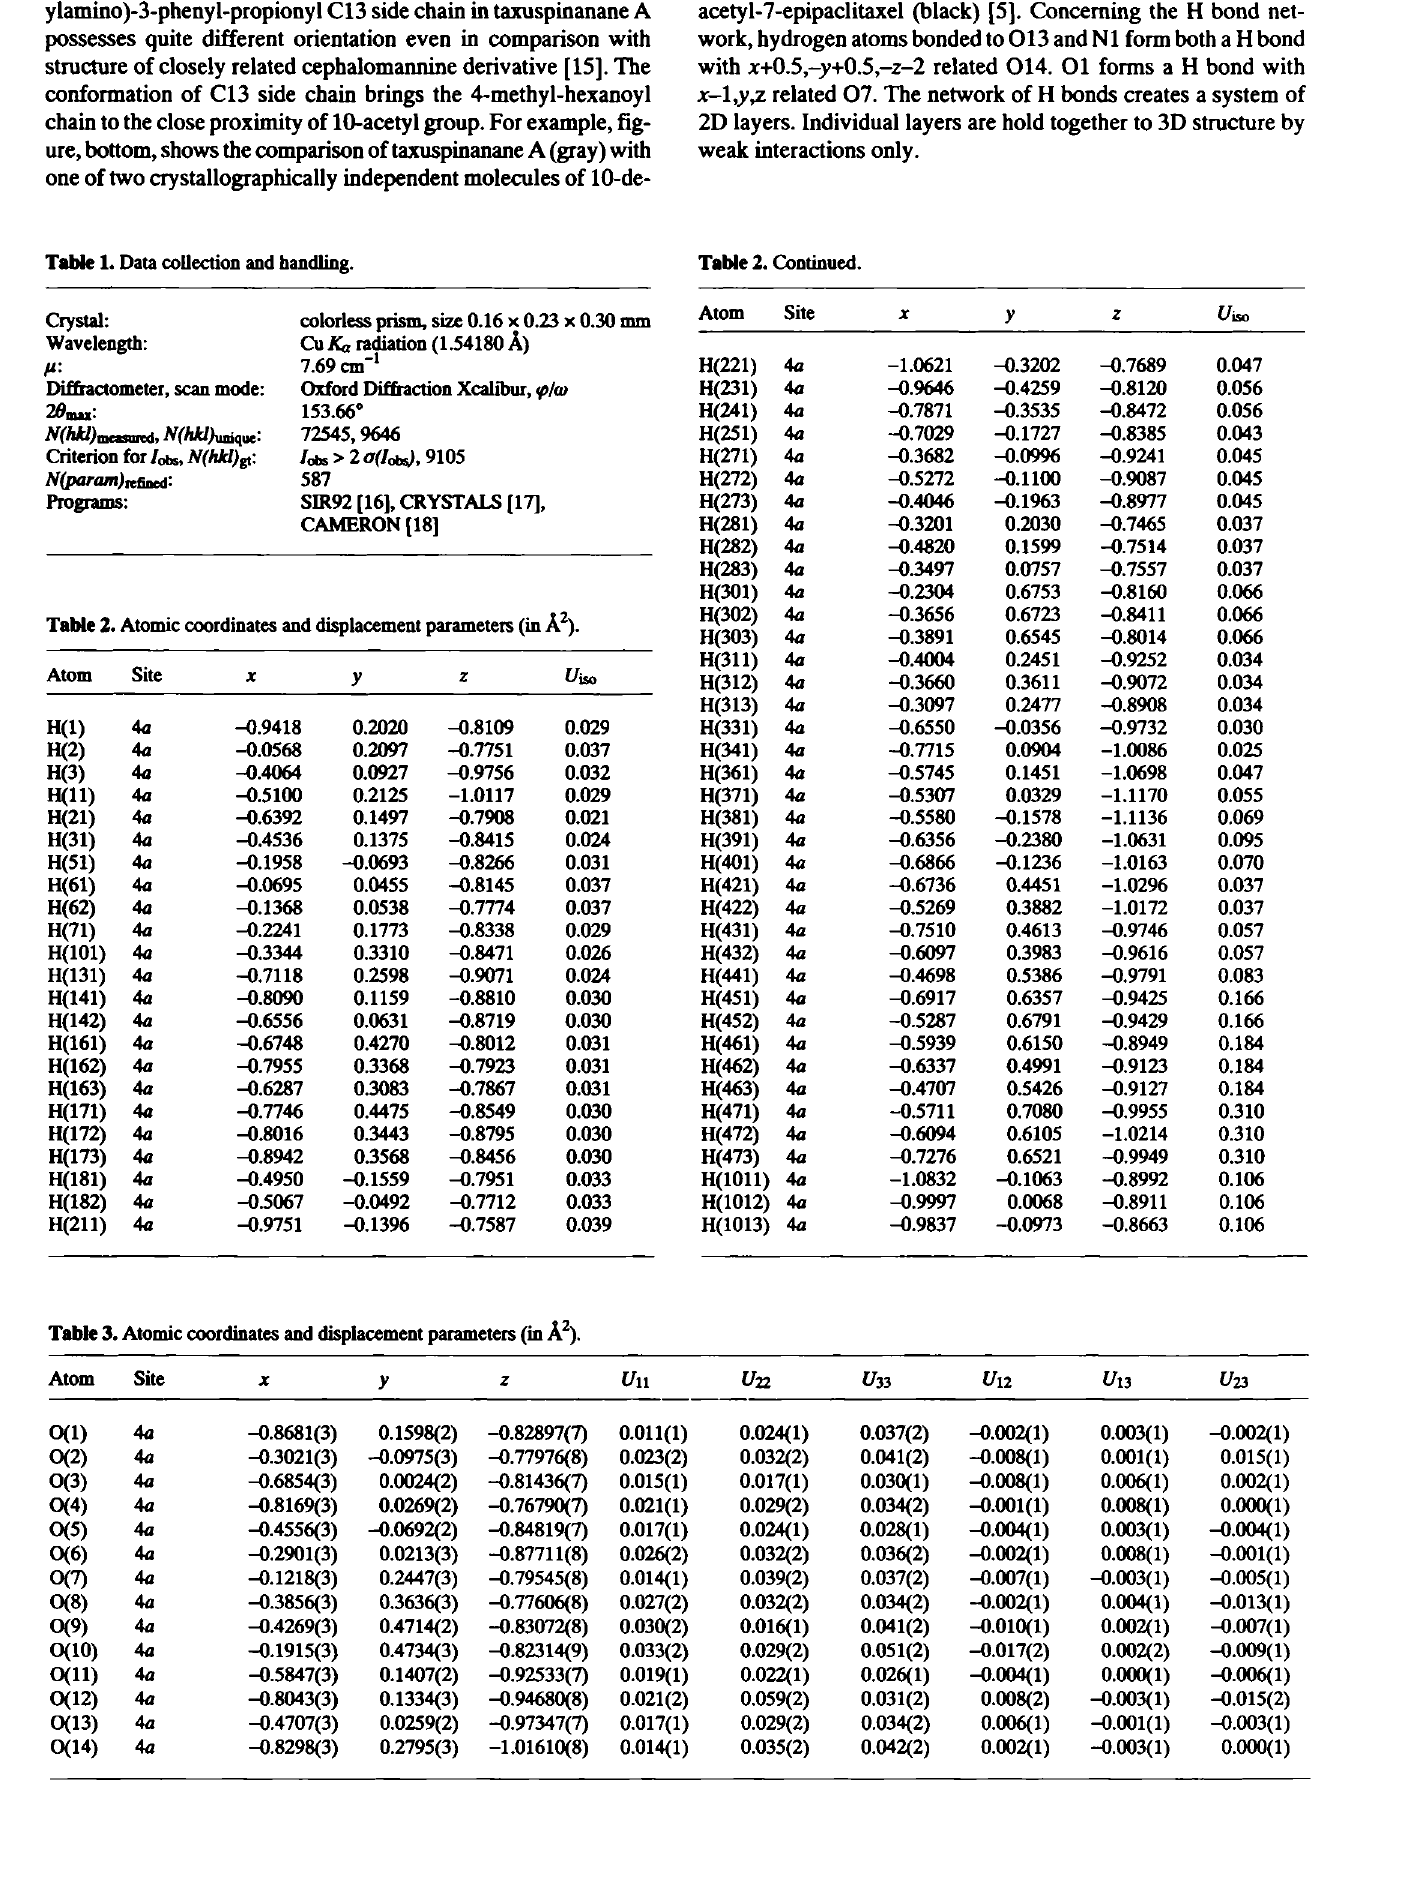
Table 2. Atomic coordinates and displacement parameters (in Ä 2 ).